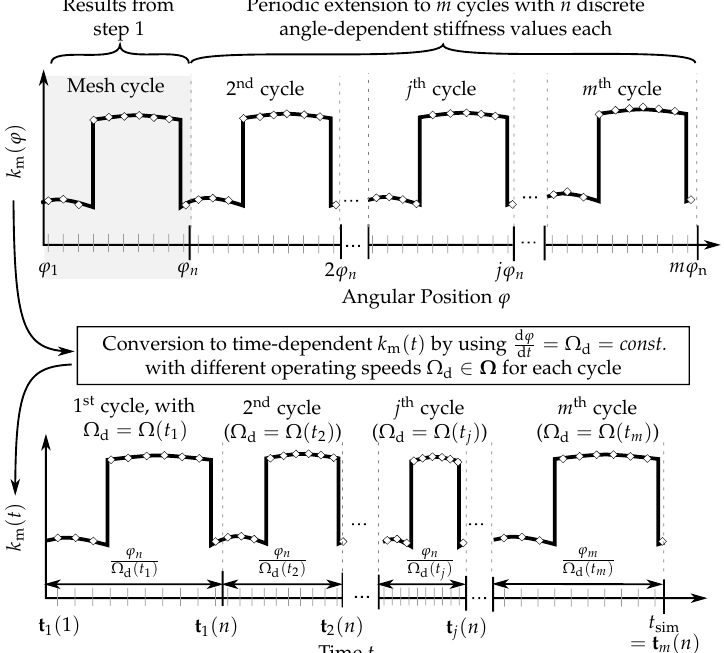
Figure 6. Procedure to determine the time-varying mesh stiffness k m ( t ) using k m ( ϕ ) from step 1 Ω , where Ω contains the operational speed at m time and time-depending operating speeds Ω d ∈ instances of a pre-defined speed profile. Therefore, the angle dependent mesh stiffness k m, j ( ϕ ) is expanded cyclically to m cycles with j = 1,2, . . . , m . Subsequently, the angle-dependent description of the mesh stiffness can be converted into a time-dependent relationship k m ( t ) with the kinematic = Ω d ( t j ) and the assumption of a constant rotational speed within each mesh cycle. relation ∂ϕ ∂ t As result of step 2, the time-varying mesh stiffness k m ( t ) can be determined for